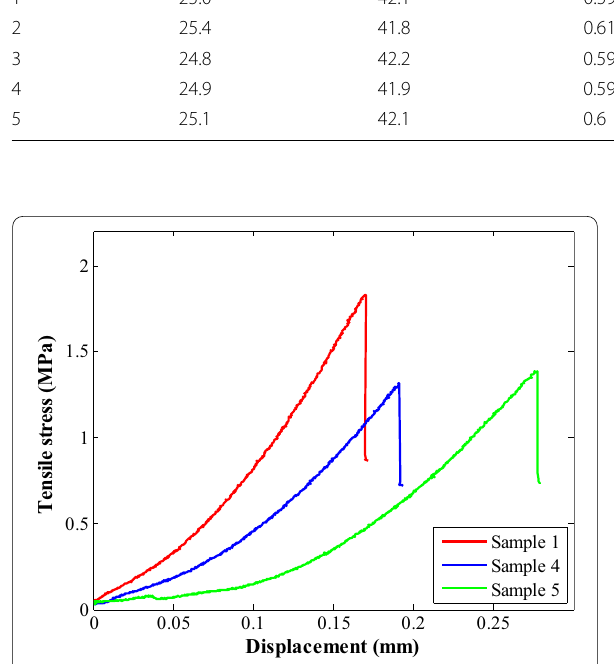
Fig. 7 Tensile stress–displacement curves when the water–cement rate was 0.42.